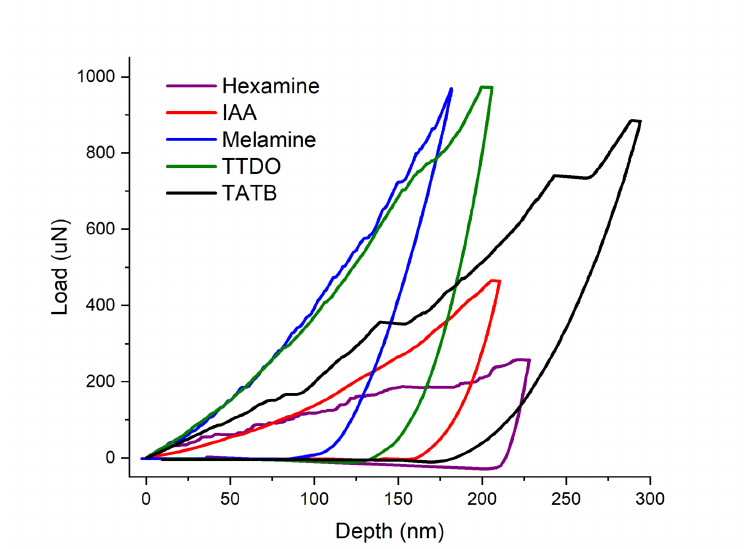
Figure 5. Typical load–depth curves for hexamine, IAA, melamine, TTDO, and TATB, with maximum indentation loads chosen so as to not exceed a maximum indentation depth of 250 nm. Load–depth data for TATB from data set in [17].